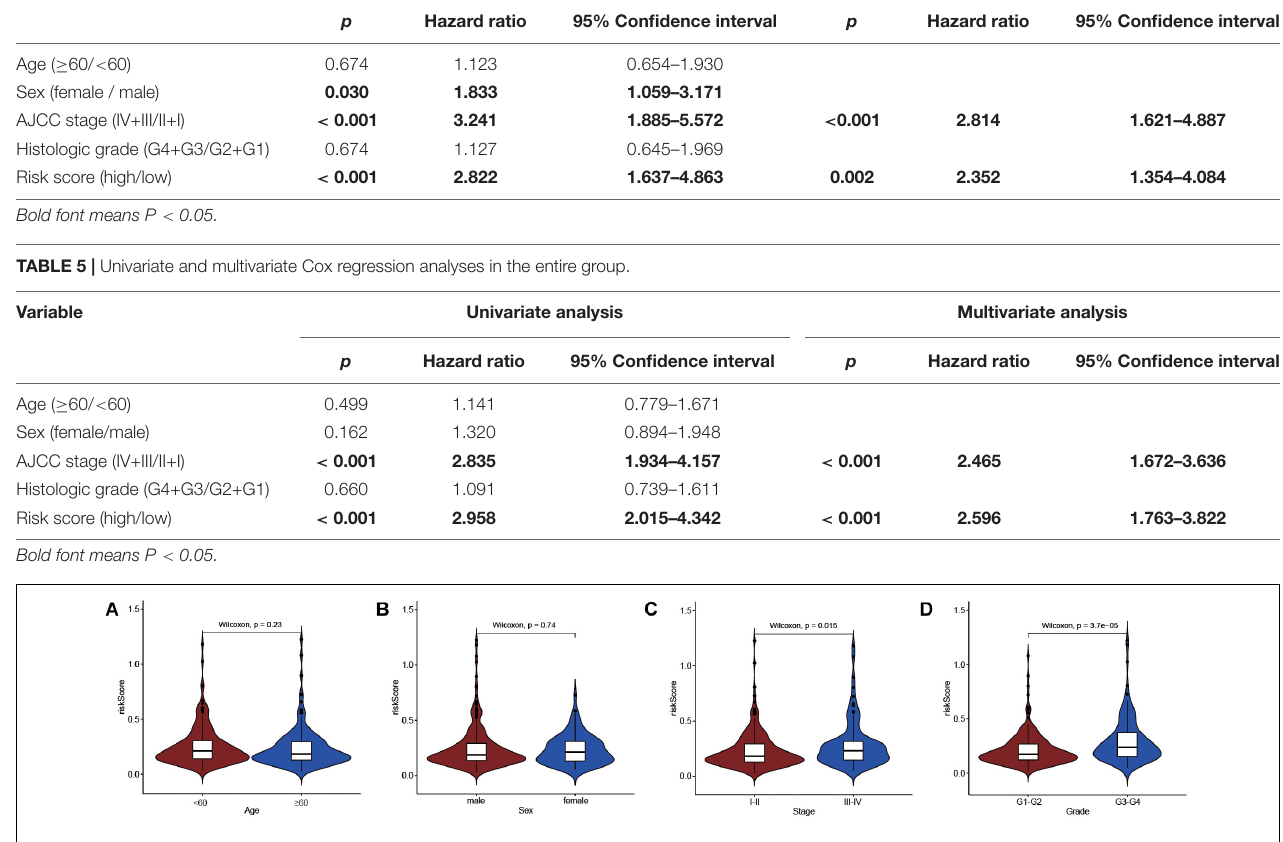
FIGURE 4 | Differential analysis between risk score and clinicopathological features. (A) risk score and age. (B) risk score and sex. (C) risk score and AJCC stage. (D) risk score and Histologic